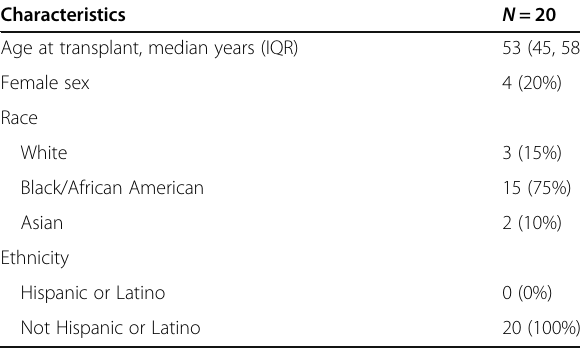
Table 3 Characteristics of transplant trial participants